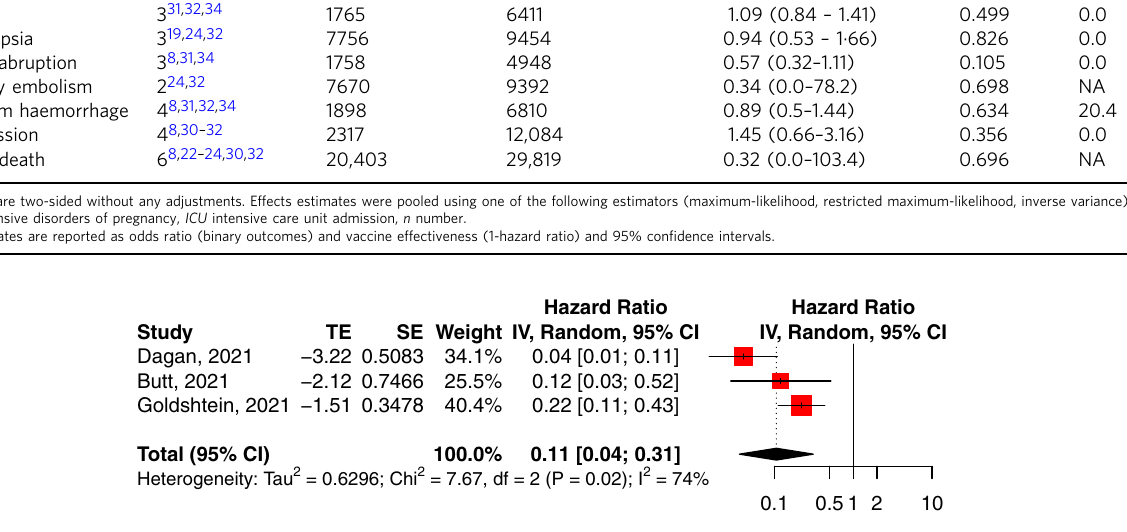
Fig. 2 Forest plot of studies reporting vaccine effectiveness. Vertical ticks within the red boxes and horizontal lines show the mean effect and 95% con fi dences interval for each study. Black diamond at the bottom shows the cumulative effect with 95% con fi dence